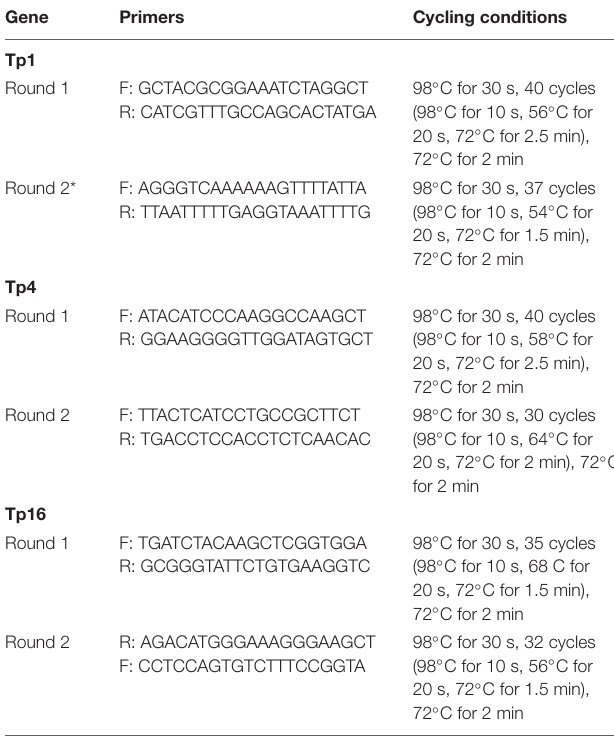
TABLE 2 | Primers and PCR cycling conditions for